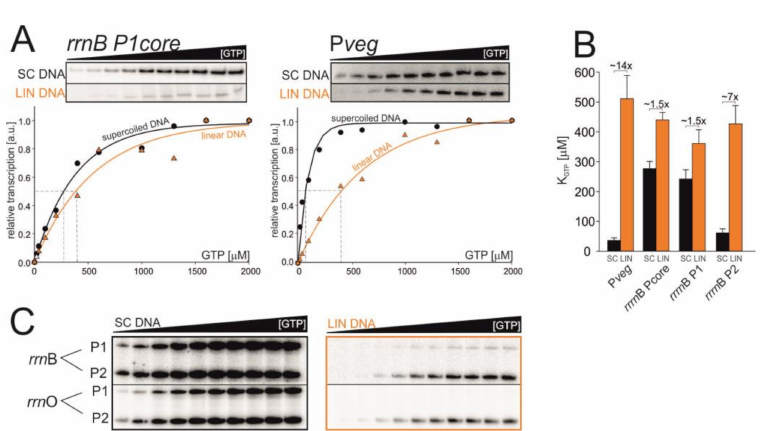
Figure 3. The affinity of RNAP for iNTP in vitro changes on different DNA templates. ( A ) Multiple- round transcriptions as a function of GTP concentration: representative primary data and their graphical comparison for rrn B P1core and P veg . The maximum signal was set as 1. ( B ) Graphical comparison of K GTP values for SC and LIN DNA templates. The values are calculated from at least four experiments, the error bars show ± SD. ( C ) Low affinity for LIN templates of full-length rrn promoter variants. Representative primary data are